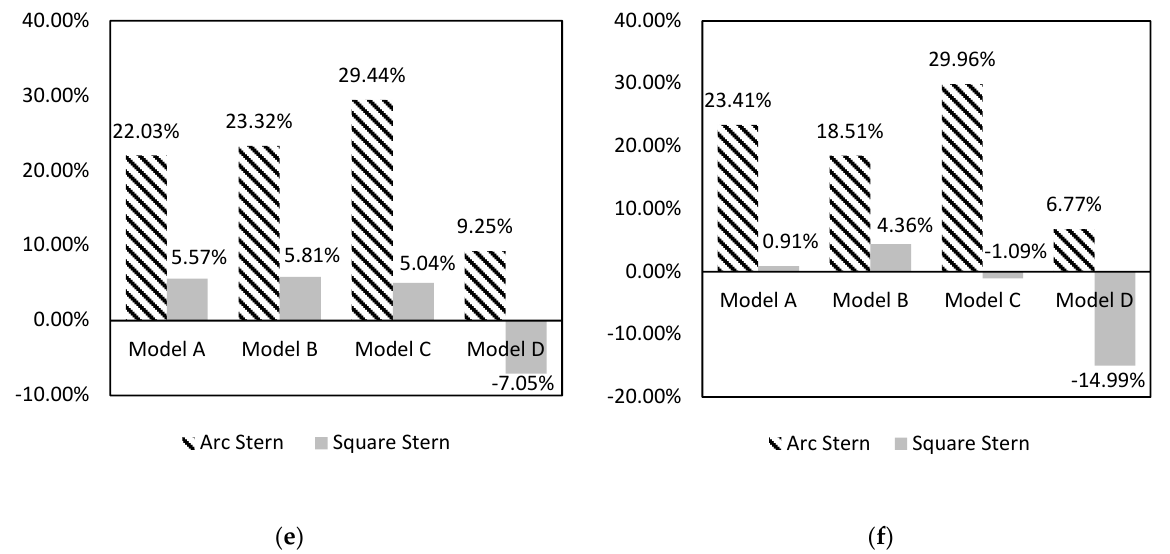
Figure 14. Histogram of drag reduction effect of each model at 6 speed points: ( a ) v = 10 m/s; ( b ) v = 13 m/s; ( c ) v = 16 m/s; ( d ) v = 19 m/s; ( e ) v = 22 m/s; and ( f ) v = 25 m/s.